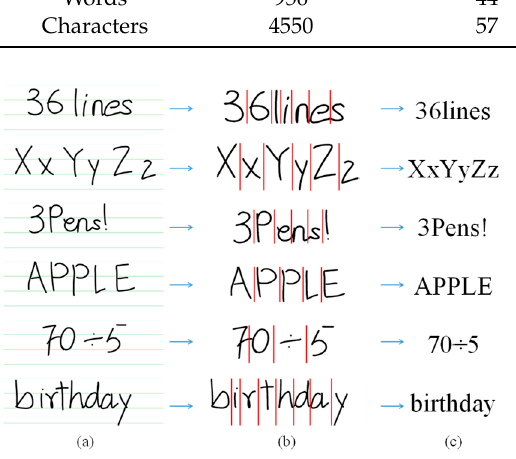
Figure 16. Some images of correct segmentation and recognition: ( a ) Images input to the system, ( b ) images with segmentation lines, and ( c ) recognition results.